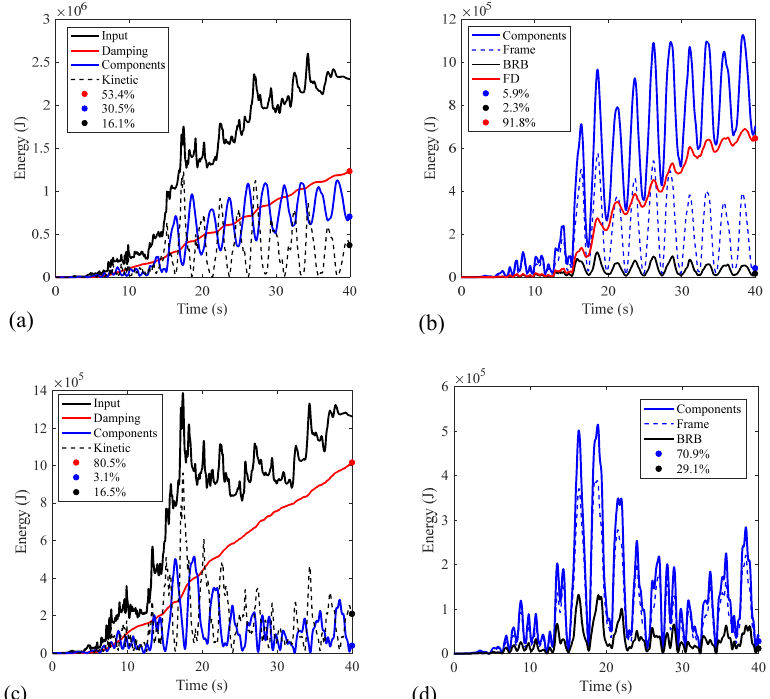
Figure 16. Seismic‑energy analysis (Imperial Valley‑06 case, PGA = 70 cm/s 2 ): ( a ) energy composition Figure 16. Seismic ‐ energy analysis (Imperial Valley ‐ 06 case, PGA = 70 cm/s 2 ): ( a ) energy composition time‑histories (FBRB‑BF); ( b ) energy dissipated by the components (FBRB‑BF); ( c ) energy composi‑ time ‐ histories (FBRB ‐ BF); ( b ) energy dissipated by the components (FBRB ‐ BF); ( c ) energy composi ‐ tion time‑histories (BRB‑BF); and ( d ) energy dissipated by the components (BRB‑BF). tion time ‐ histories (BRB ‐ BF); and ( d ) energy dissipated by the components (BRB ‐ BF).